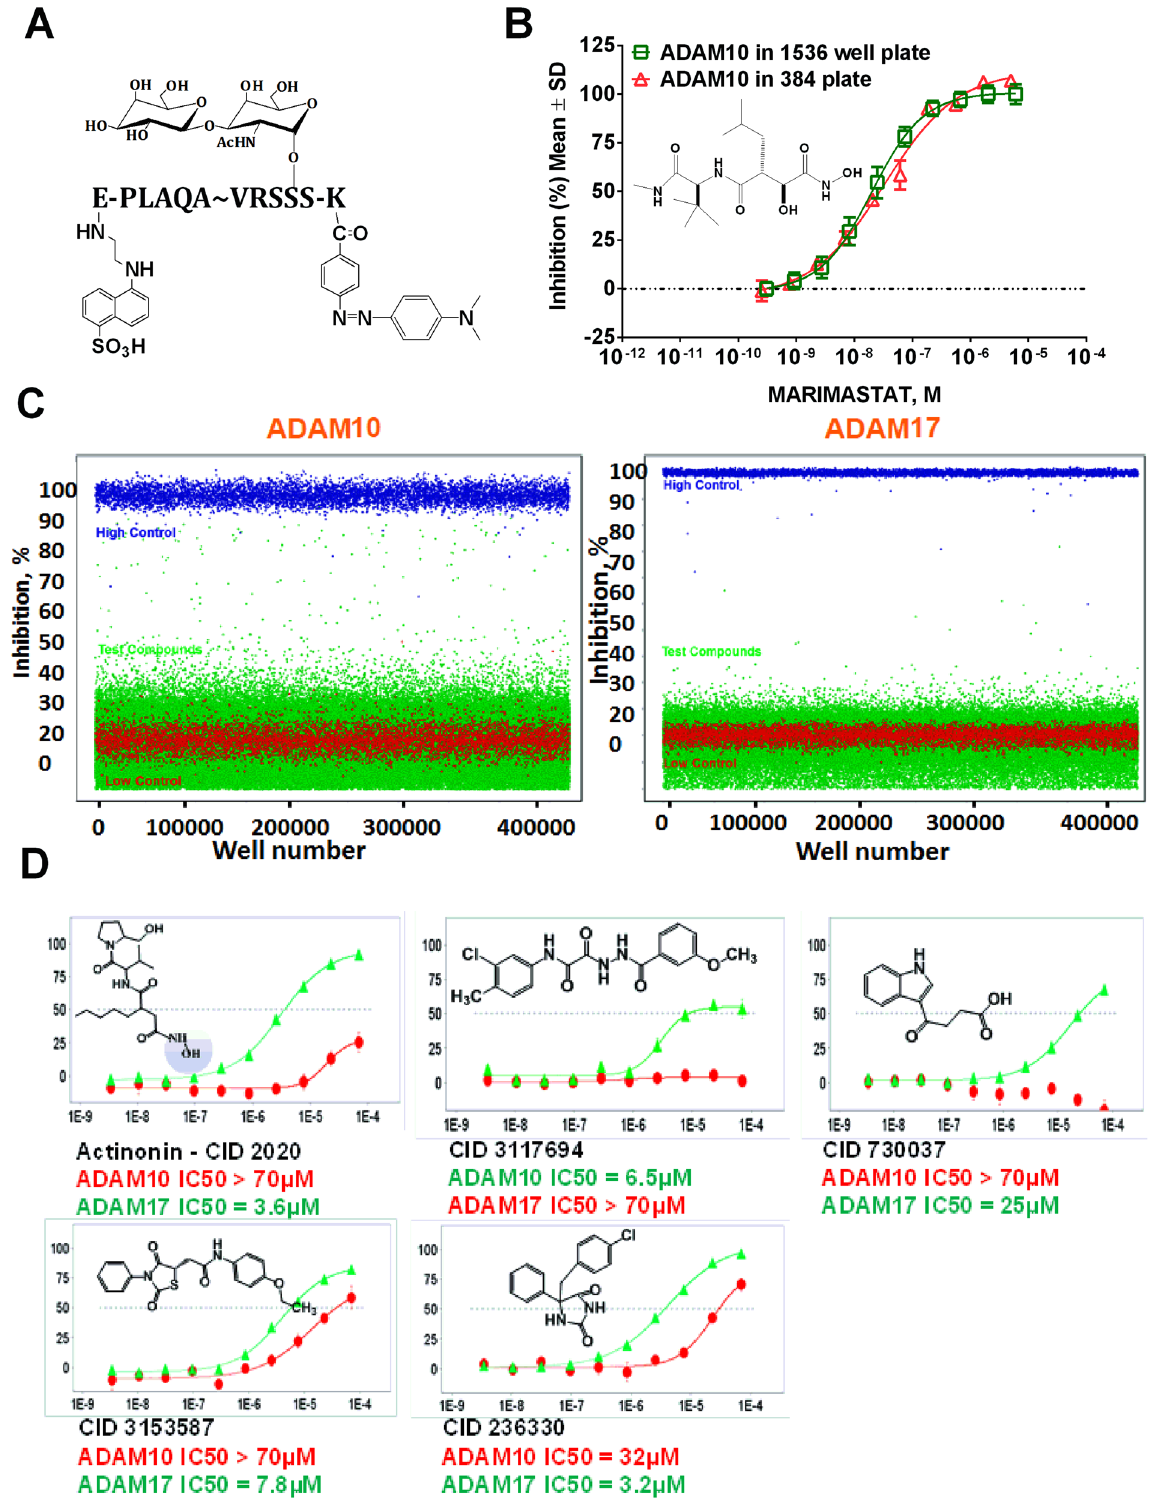
Figure 1. ADAM10 HTS assay. ( A ) Structure of glycosylated ADAM10 and ADAM17 uHTS substrate. ( B ) Pharmacological control (marimastat, structure shown on the graph) study with ADAM10 in 384 and 1536 well plate formats. ( C ) Scatter plot of ADAM10 and ADAM17 primary uHTS campaign. Green dots–test compounds, blue dots–100% inhibition control (marimastat at 10 µ M), red dots–0% inhibition control (wells with uninhibited enzymatic reaction). ( D ) Examples of structures and dose response curves of HTS hits selected for follow-up studies. Hydroxamate is shown in a blue circle. Y-axis-%inhibition, X-axis–molar concentration of